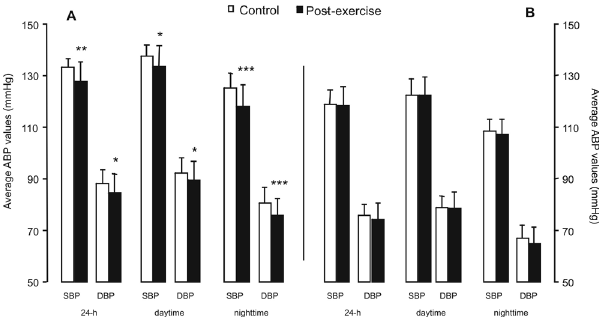
Figure 3 - Average twenty-four hour (24-h), daytime and nighttime ABP values after a single exercise session (post-exercise) or a nonexercise con- trol period (control) for patients with control BP above (A) and below (B) the median value. SBP: systolic BP. DBP: diastolic BP. Asterisks denote a significant difference from control period (*: p<0.05; **: p=0.001; ***: p ≤ 0.0001)